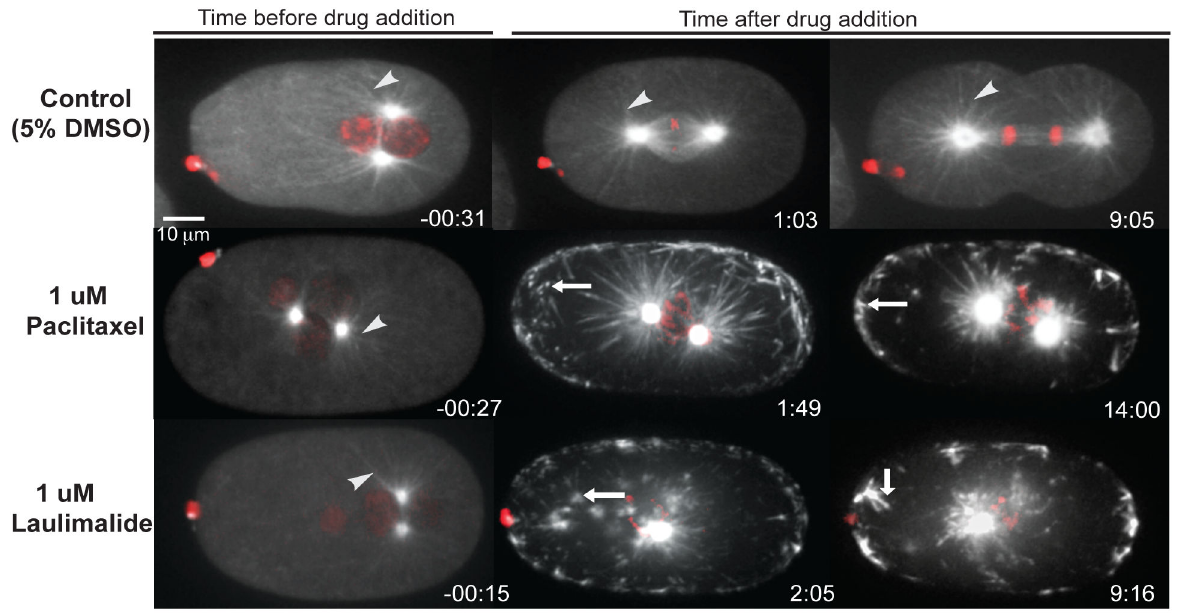
Figure 3. Laulimalide stabilizes microtubules at high concentration. Confocal images of embryos expressing GFP-tubulin and mCherry-histone are shown. The posterior of the embryos is to the right. Control embryo treated with 5% DMSO divides normally. The white arrowheads point to microtubule fibres. Microtubule fibres were present in all time frames in control embryo. Embryos treated with paclitaxel and laulimalide displayed prominent microtubule defects after drug addition. Spindle pole separation did not occur in these embryos. Tubulin aggregates in the cytoplasm (white arrows) were seen in both paclitaxel and laulimalide-treated